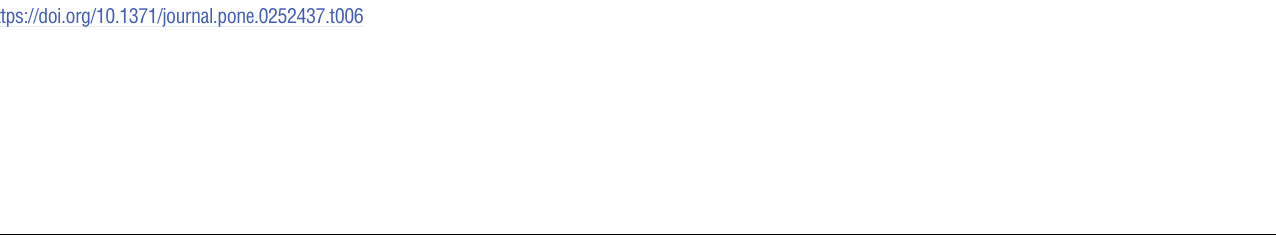
Table 6. The impact of different nitrogen and boron doses and their interaction on micro mineral contents in watermelon flesh. Treatments Iron (mg kg -1